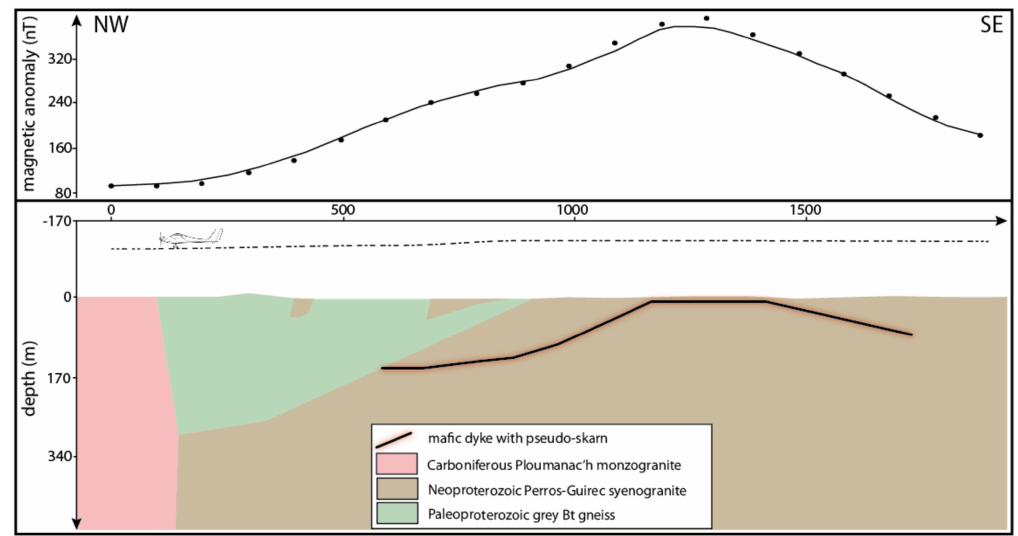
Figure 6. Regional magnetic modelling along the coast (profile location on Figure 4a). Upper window: measured regional magnetic anomaly (dots) compared to the computed magnetic model effect (line). Lower window: colors of modelled geological units are consistent with Figure 2. Taking into account a realistic “geological magnetic background”, a good fit of the regional magnetic anomaly can be achieved with a “ribbon-shaped” pseudo-skarn developed along a low-dipping mafic dyke (in black with red shadow—exaggerated in thickness). Vertical exaggeration is 1 for all displayed